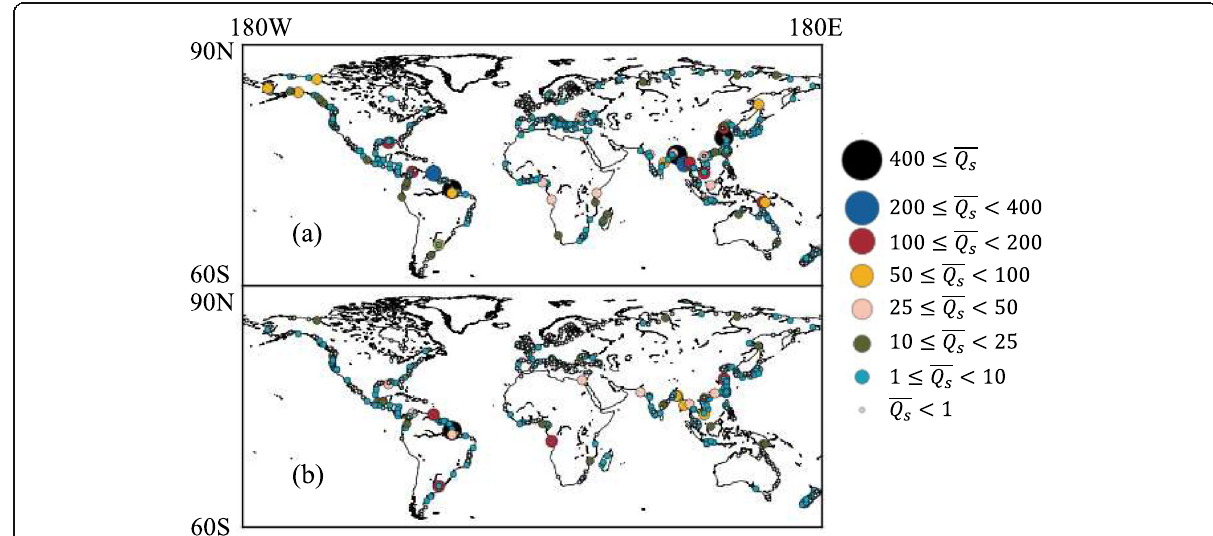
Fig. 7 Annual suspended sediment flow [Mt/a]. a Milliman and Farnsworth (2011) and b CTL simulation